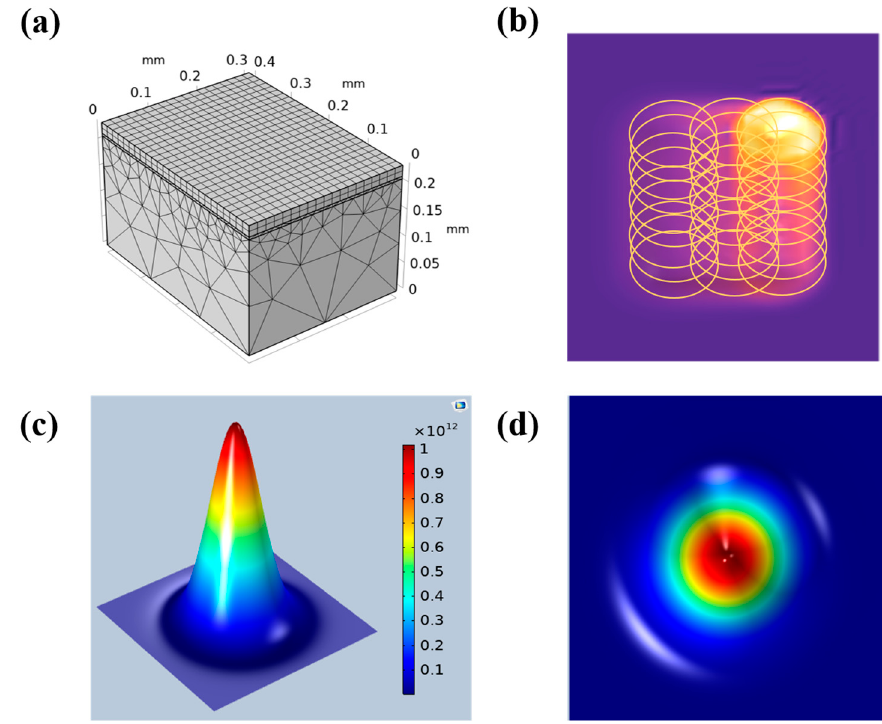
3 of 17 Table 1. The chemical composition of 2024 aluminum alloy. Element